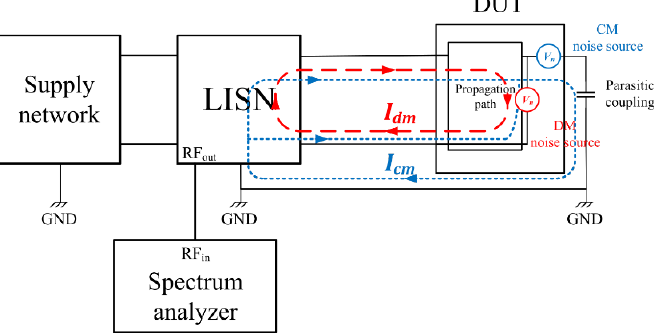
Figure 1. Block diagram of a switching system, noise sources and propagation paths for common mode (CM) and differential mode (DM), and EMI